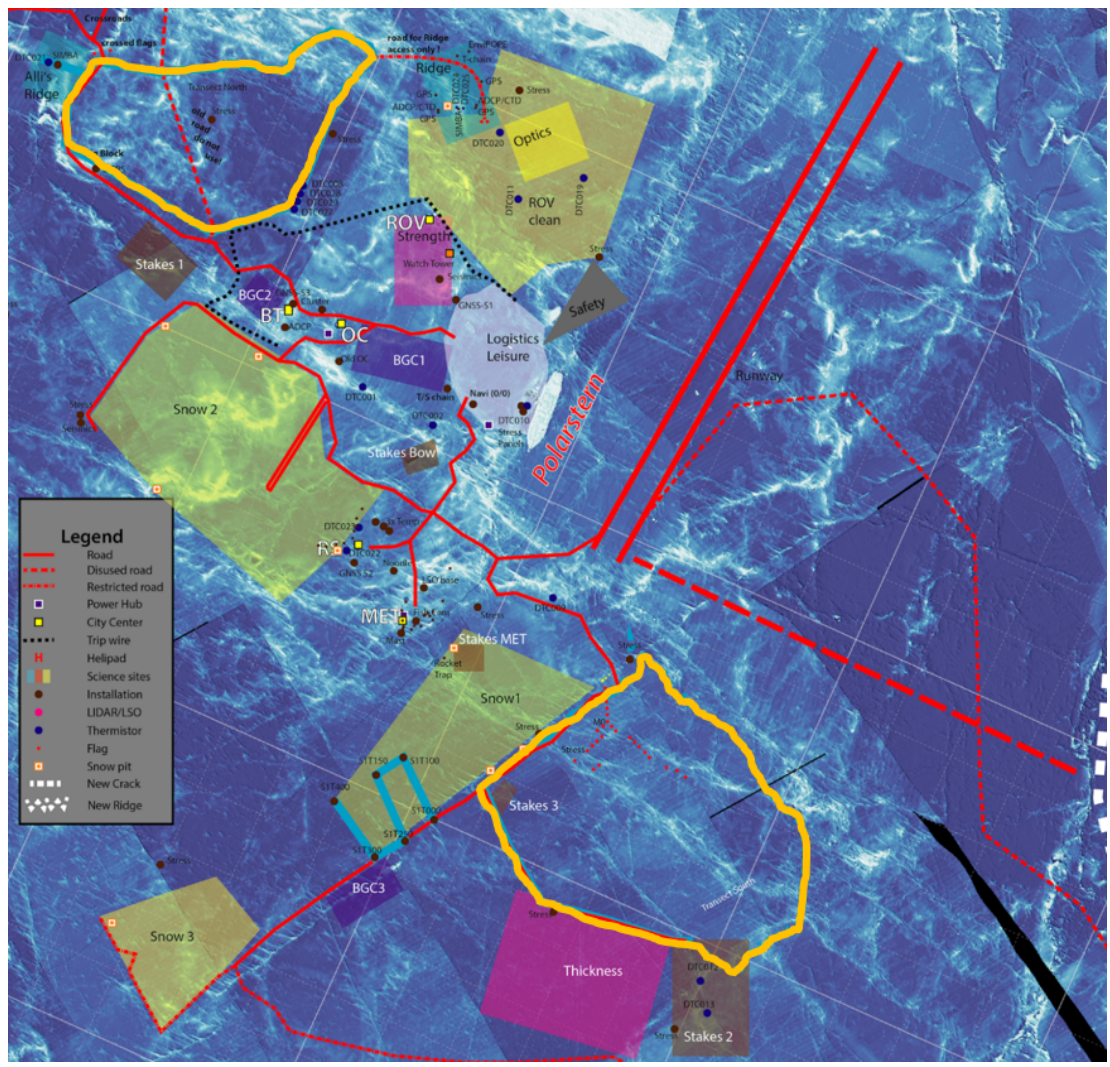
Figure 2. Annotated schematic of the Central Observatory (CO) around R/V Polarstern . The schematic is overlaid on a postprocessed airborne laser scanner map, acquired on 21 February 2020. The remote sensing site is denoted by “RS”. The northern (top left) and southern (bottom right) transects are outlined in bold